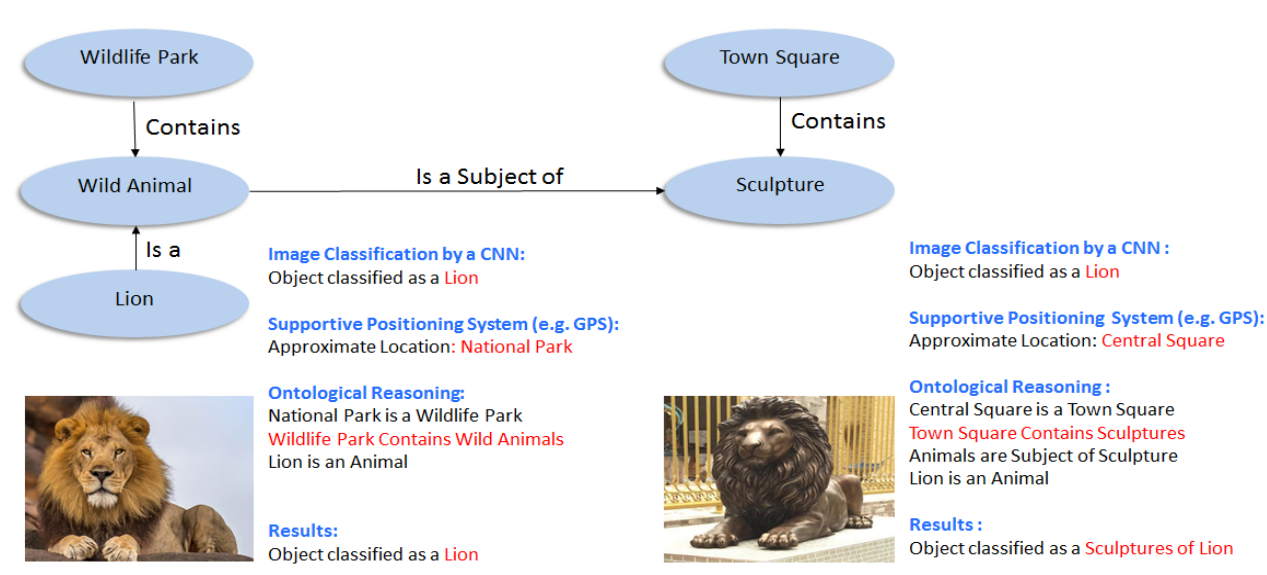
Figure 3 . Employing background knowledge over image classification for image